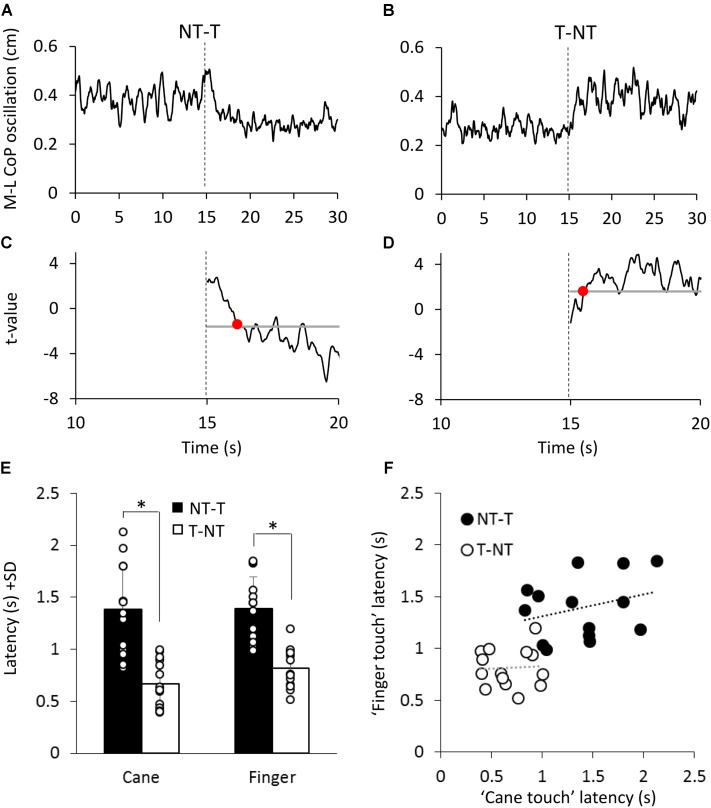
(A,B) Mean M-L CoP oscillation of one subject during NT-T and T-NT haptic shift (dotted line at 15 s) under the ‘cane touch’ condition. (C,D) The traces show the t-values calculated by comparing all the successive mean values of oscillation with the mean value of all pre-shift period. The horizontal line indicates the critical t value corresponding to α = 0.05 probability. The time at which the t-value bypassed the critical value and remained above or below it for at least 100 ms (red dot in C,D) was set as the latency at which the haptic shift began to significantly affect the M-L CoP oscillation. (E) Mean time intervals from the haptic shift to the change in CoP oscillation. These latencies were longer for the addition (NT-T, black bars) than for the withdrawal (T-NT, white bars) of the haptic information. There was no difference in latency between cane touch and finger touch condition. (F) For each subject, the latency calculated for the ‘finger touch’ condition is plotted against the latency of the ‘cane touch’ condition both for the NT-T (black circles) and for T-NT shift (open circles). Across subjects, there was no significant relationship between the latencies of cane and touch within condition. ∗Indicates a significant difference (p < 0.05).